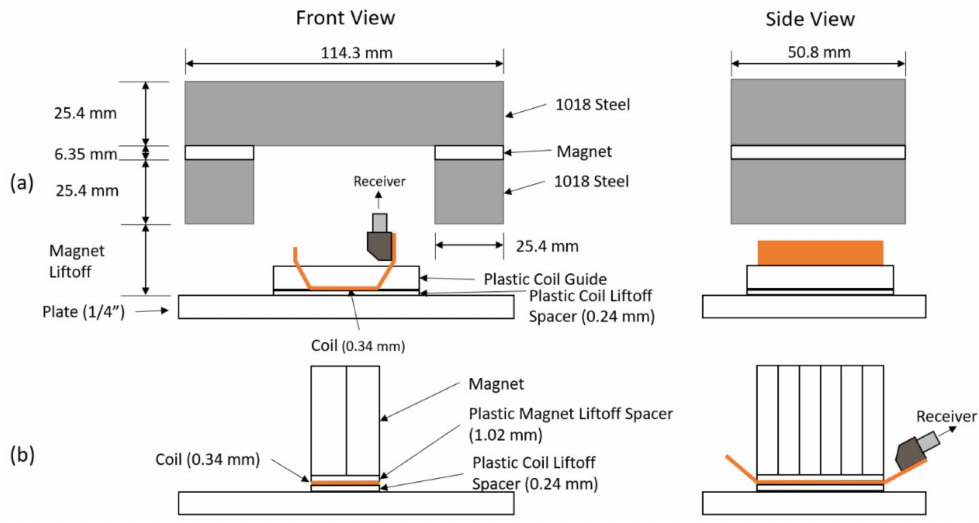
Figure 9. EMAT Front and Side Views: ( a ) MS-EMAT; ( b ) PPM